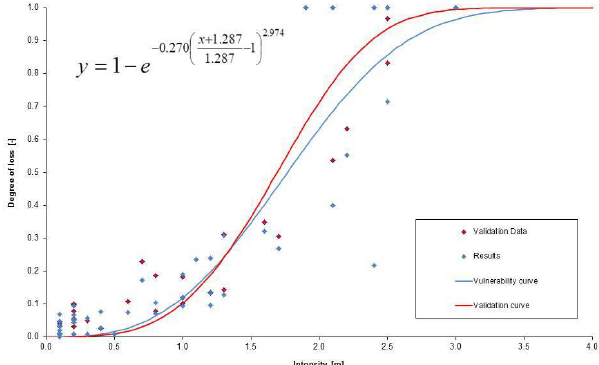
Fig. 4. Vulnerability curve (blue) and validation curve (red) devel- oped using the buildings that were affected during the 1987 event in Ennewasser and Gand. The curves express the relationship be- tween the degree of loss (0–1) and the intensity of the debris flow expressed as debris height (m) (Papathoma-K¨ohle et al., 2012).